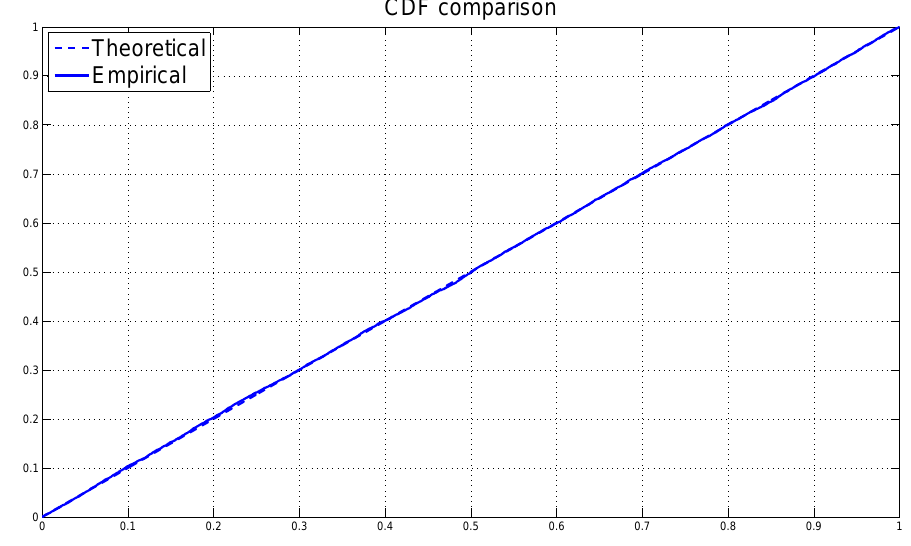
Figure 4. Goodness-of-fit test via the scatter plot ( top ) and the histogram ( bottom ) of the PITs produced by the fitted TSCD-W model based on simulated transaction data. The two horizontal lines in the histogram plot are the 95% confidence intervals of the uniformity, constructed under the normal approximation of a binomial distribution, the calculation of which is detailed in Diebold et al. (1998).